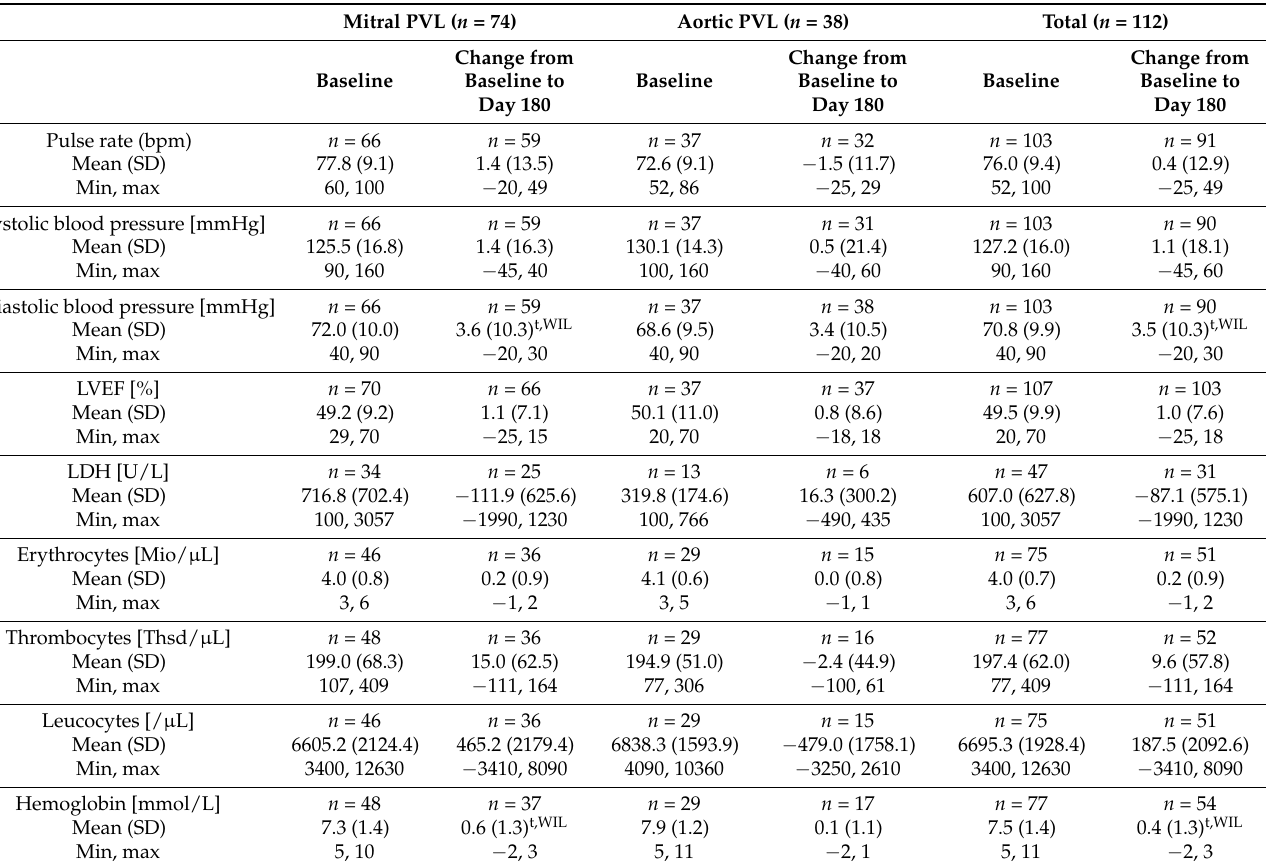
Table 3. Baseline and changes from baseline to Day 180 in vital signs and laboratory evaluations (FAS). Mitral PVL ( n = 74) Aortic PVL ( n = 38) Total ( n = 112) Change from Change from Change from Baseline Baseline to Baseline Baseline to Baseline Baseline to Day 180 Day 180 Day